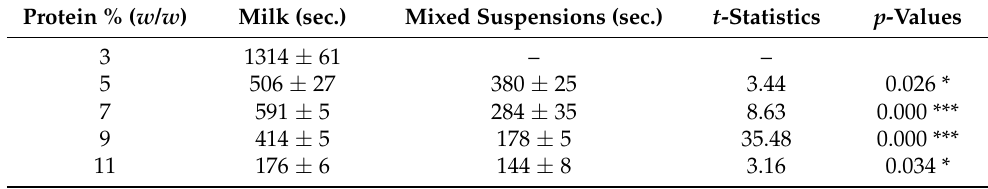
Table 2. Heat stability (in sec.) of milk samples and mixed protein suspensions represented as mean ( ± standard error), and comparisons between milk and mixed protein suspensions within each protein concentration according to a Student’s t